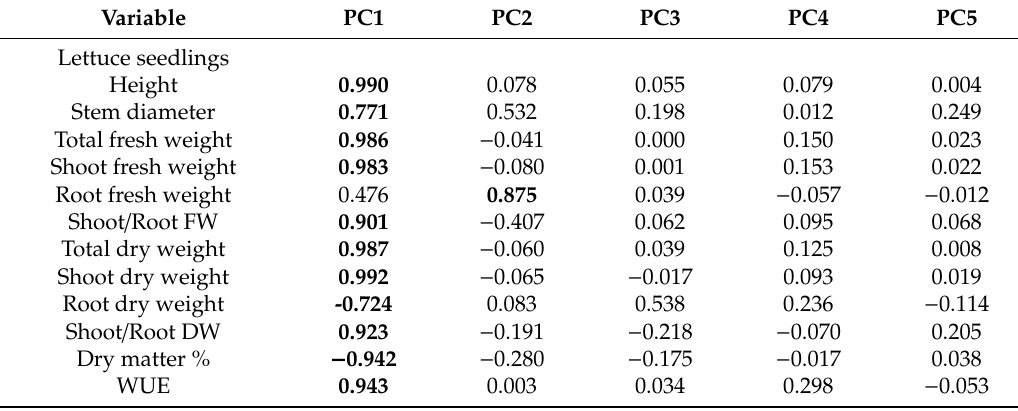
Table 5. Correlation of variables to the factors of the principal components analysis (PCA) based on factor